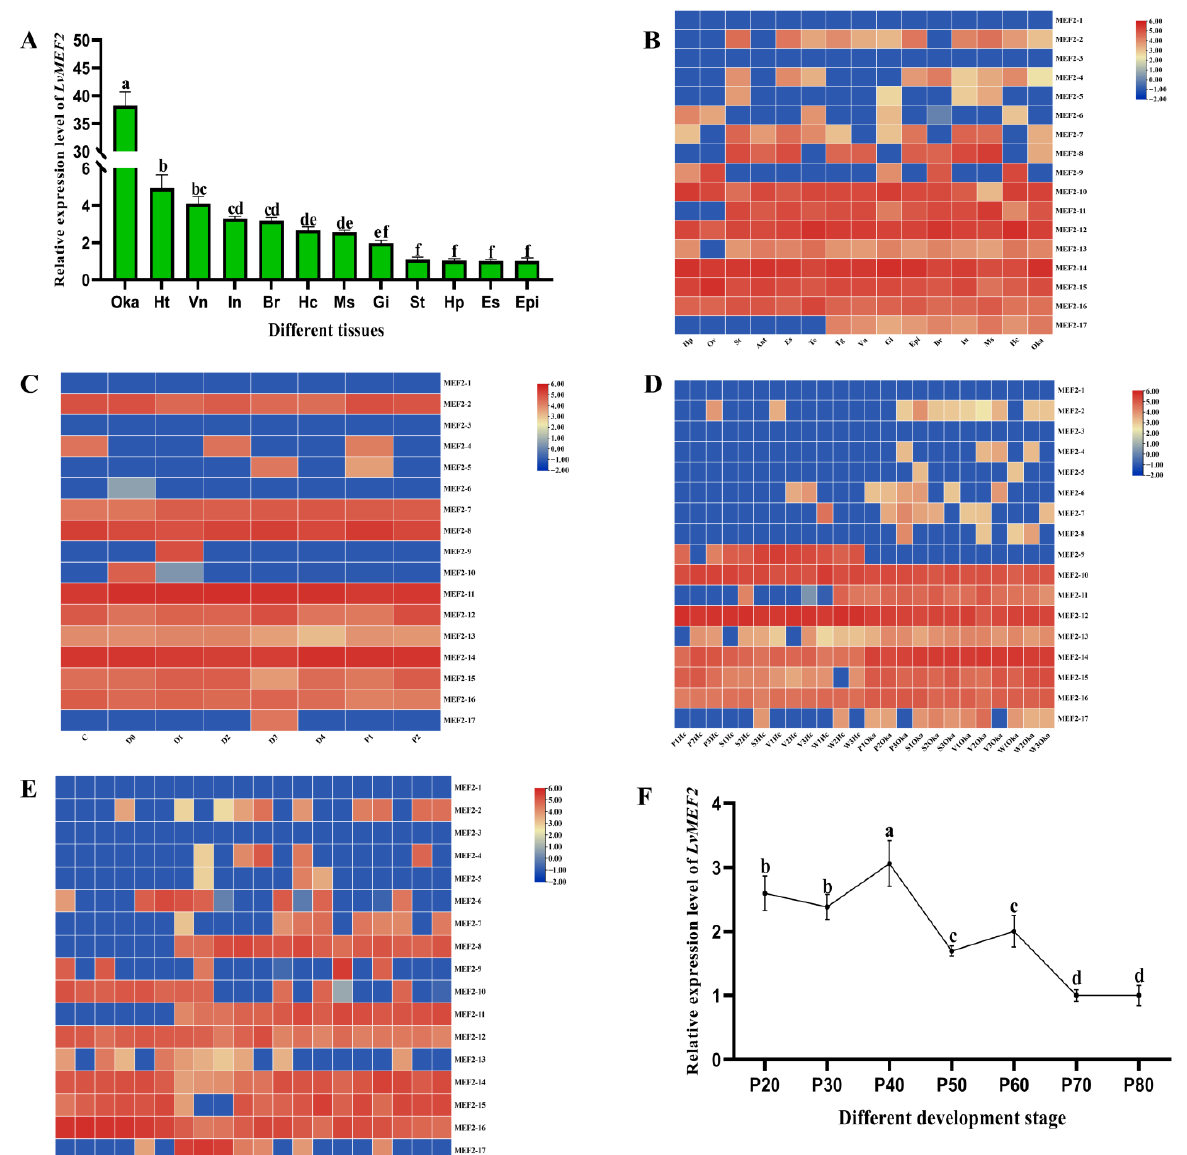
Figure 4. The expression profiles of LvMEF2 . ( A ) Expression of total LvMEF2 in different adult shrimp tissues, heart (Ht), epidermis (Epi), muscle (Ms), lymphoid organ (Oka), stomach (St), gills (Gi), eye stalk (Es), brain (Br), hemocytes (Hc), hepatopancreas (Hp), intestine (In), and abdominal nerve (Vn). These results were based on three independent biological replications and shown as mean values ± SD. Significant differences in the gene expression levels between the three treatments are shown as a, b, bc, cd, de, ef, and f. ( B ) The expressions of LvMEF2 splice variants in different tissues. heart (Ht), epidermis (Epi), muscle (Ms), lymphoid organ (Oka), stomach (St), gills (Gi), eye stalk (Es), brain (Br), hemocytes (Hc), hepatopancreas (Hp), intestine (In), and abdominal nerve (Vn), ovary(Ov), antenna(Ant), testis(Te), thoracic ganglion(Tg). ( C ) The expressions of LvMEF2 splice variants at different molting stages, inter molting (C), pre-molting (D0, D1, D2, D3, and D4), and post-molting (P1 and P2). ( D ) The expressions of LvMEF2 splice variants in Oka, hepatopancreas, and hemocytes after infection by different pathogens, i.e., Vibrio parahaemolyticus (V), Staphylococcus aureus (S), and WSSV (W); sterile phosphate-buffered saline (PBS) (P) was set as the control group. Three biological replicates were taken after each pathogen infection. ( E ) The expressions of LvMEF2 splice variants at different early developmental stages. Zygote (Zygo), 2 cells (C2), 4 cells